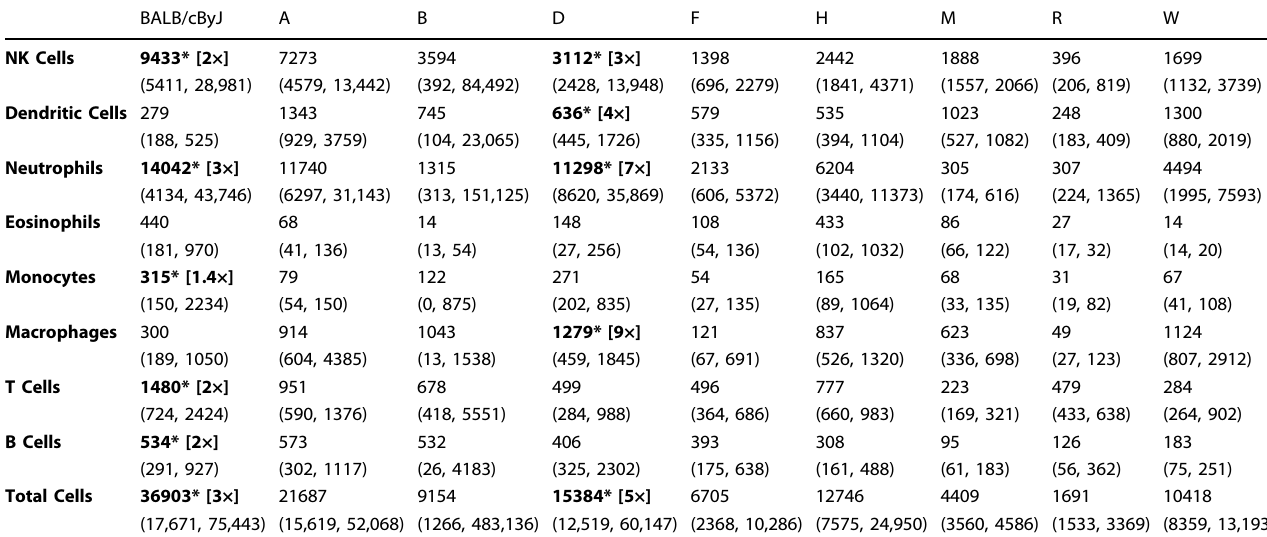
Table 1. Cell pro fi les within fl uid recovered from diffusion chambers implanted in BALB/cByJ and 8 CC-RIX Lines. BALB/cByJ